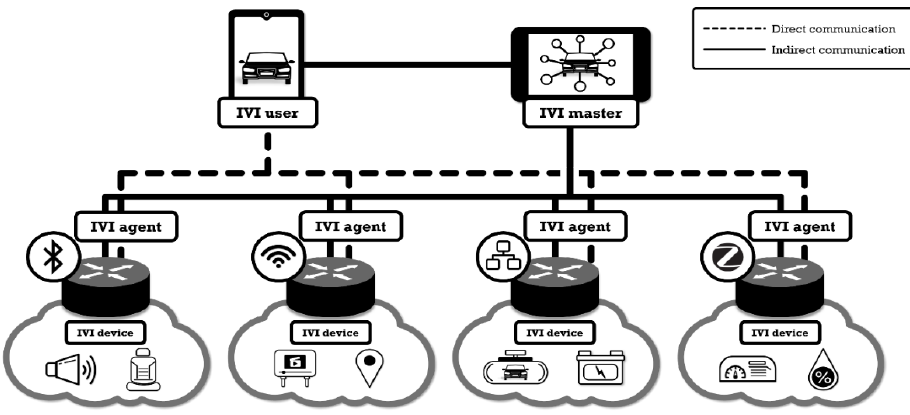
Figure 3. Agent based IVI (A-IVI) system architecture .